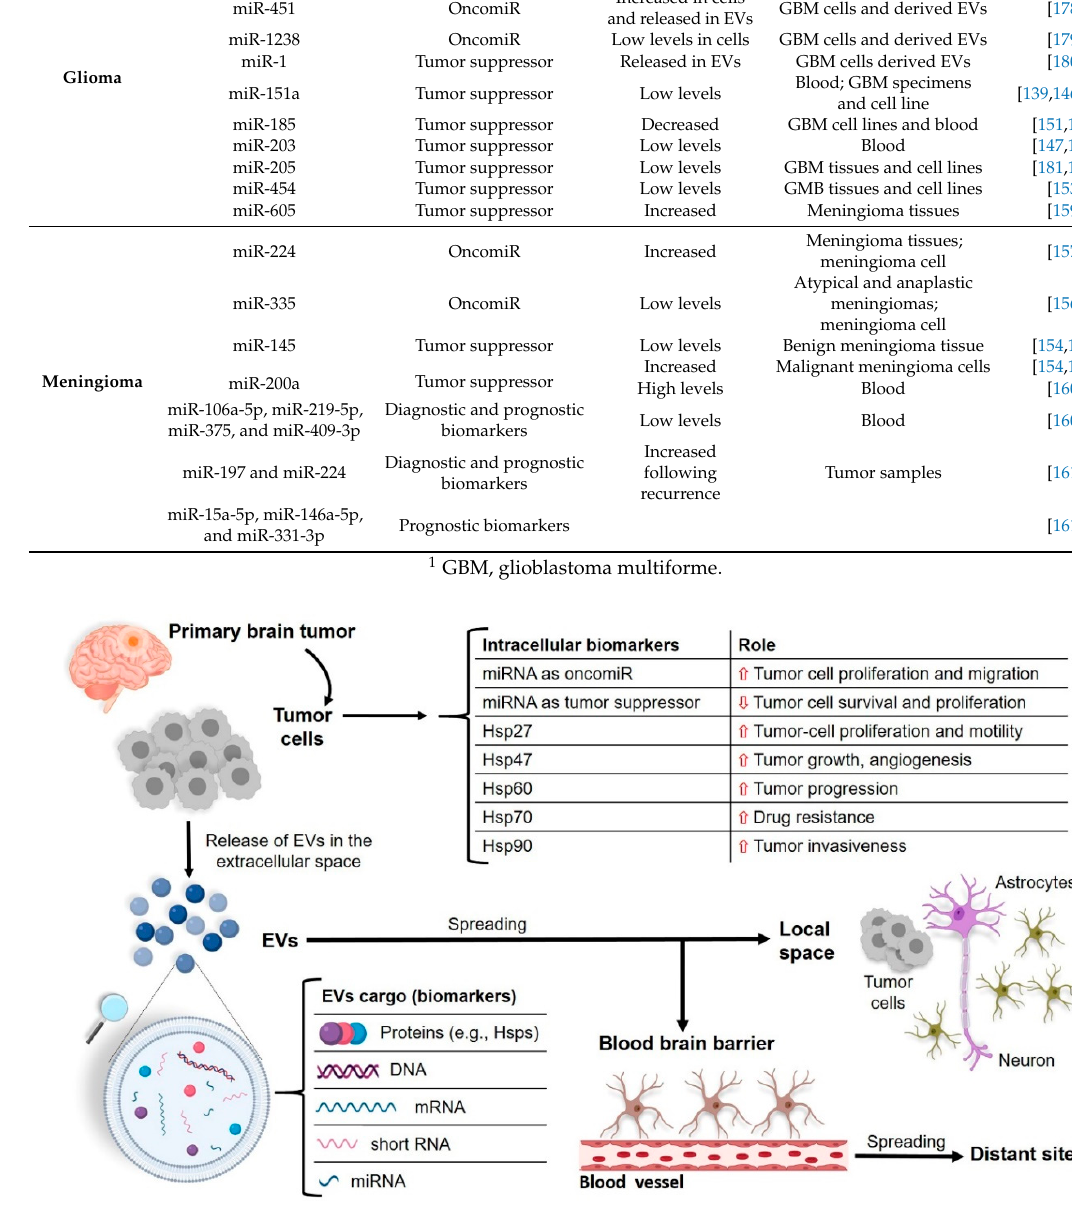
Figure 1. Schematics of the production and migration of extracellular vesicles (EVs) released by brain tumors and their local and distant cell targets (top half of the figure) with the components of their cargo discussed in this article (bottom half).